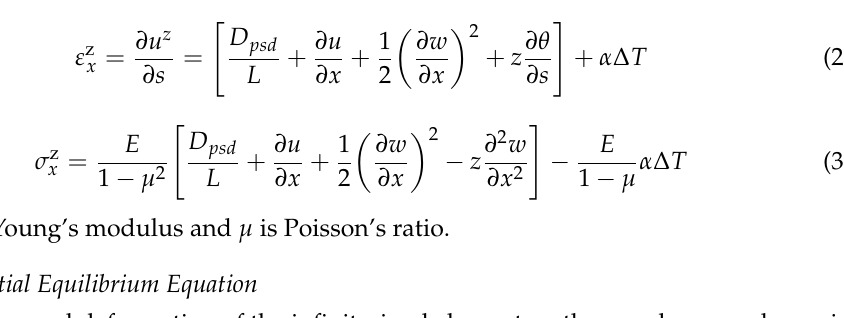
The force and deformation of the infinitesimal element on the x-z plane are shown in Figure 2 .